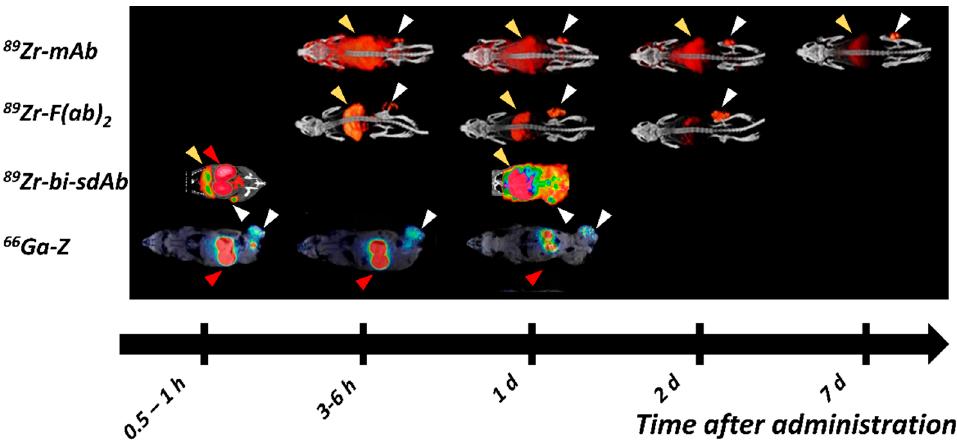
Figure 2. Imaging of HER1 expression (white arrows) in xenografted mice using 89 Zr-labeled monoclonal antibody (cetuximab [87]), F(ab ′ ) 2 -fragement (cetuximab-F(ab ′ ) 2 [87]), biparatopic dimer of single domain antibodies (sdAb) [135], and 66 Ga-labeled affibody molecule (Z 2377 [138]). Yellow arrows point to the uptake in liver and red arrows in kidneys. These images were originally published in J Nucl Med [87] © SNMMI; Sci Rep [135] and Pharmaceutics [138].